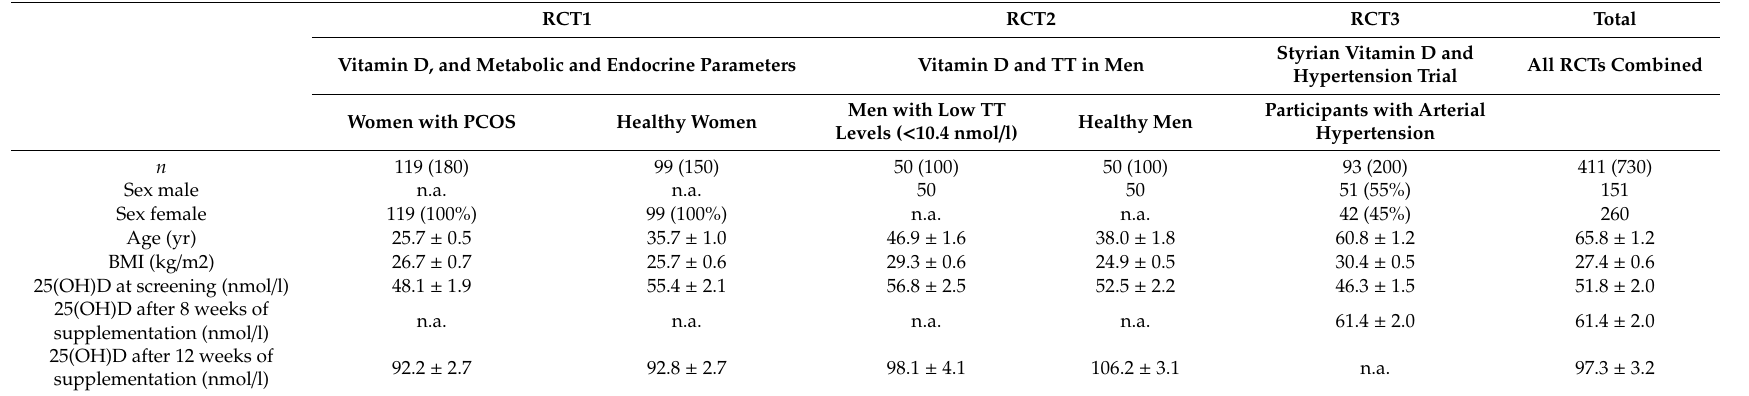
Table 2. Demographic data of the